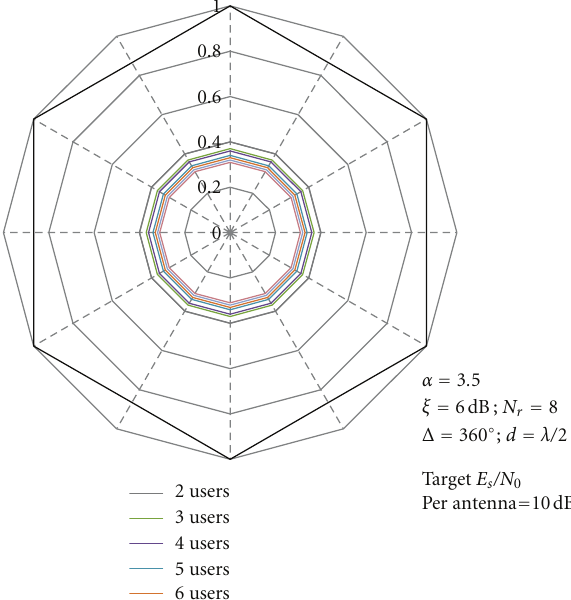
Figure 7: Hybrid FRF scheme with varying number of users.